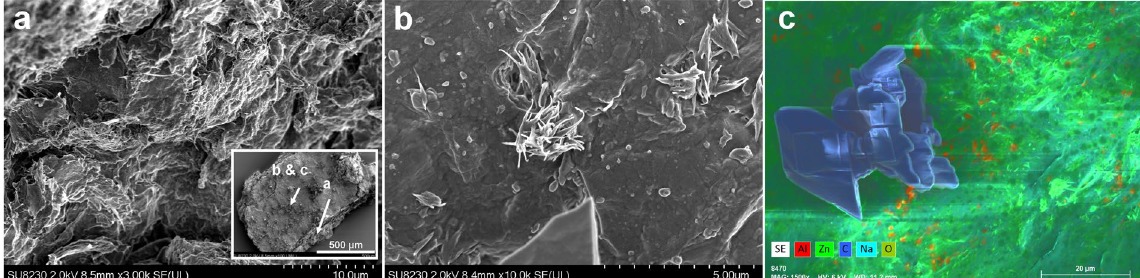
Figure 7. SEM images of a segment (approx. 0.7 × 1.5 mm 2 lateral size) of the sediment shell from LDH-BA (b-PES in water, cf. Fig. 6b). The locations of images ( a ) to ( c ) are indicated in the insert of ( a ), which shows the top view on the outer shell surface. ( a ) Layered shell structure, displayed by a terrace morphology of the edge.